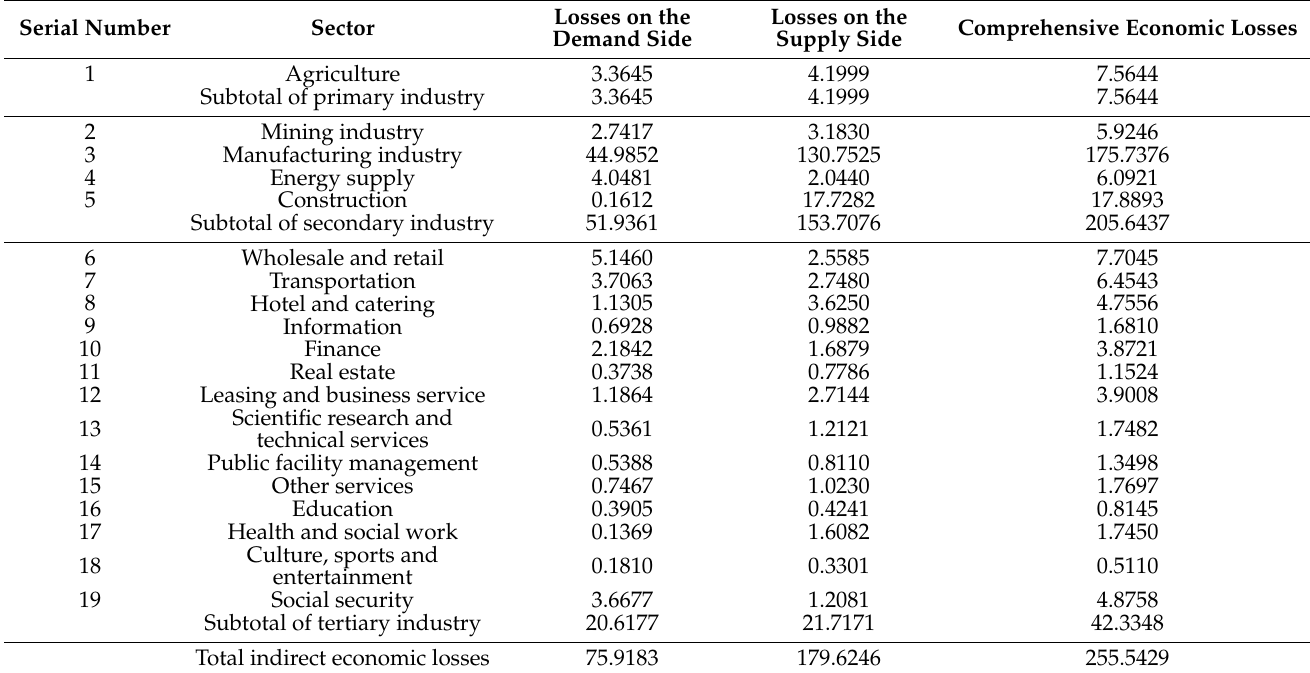
Table 3. Related losses of various sectors in China (unit: CNY 100